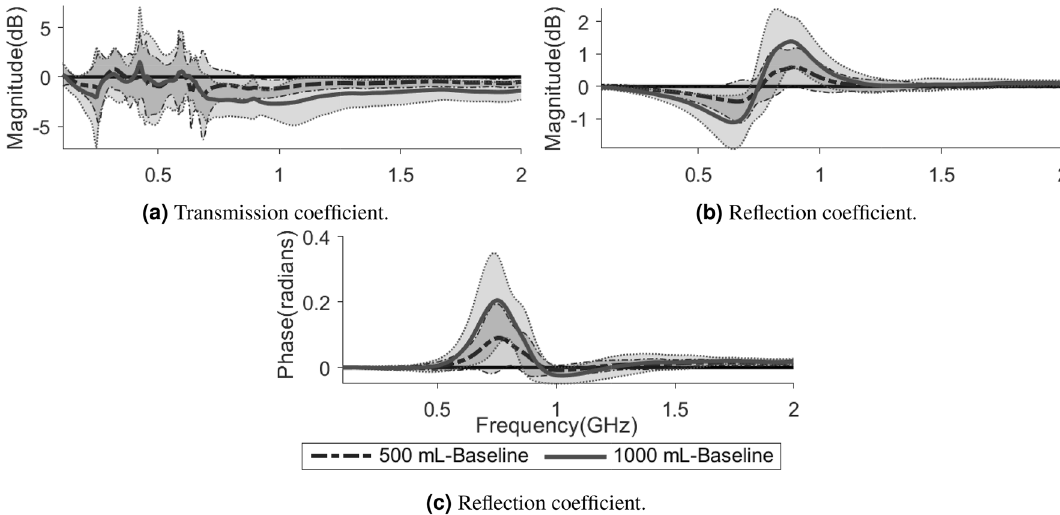
Figure 3. Some examples of the changes relative to baseline caused by hemoperitoneum in transmission coefficient magnitude ( a ) and reflection coefficient magnitude and phase ( b , c ). The lines show the average values across all subjects while the shaded areas show the standard deviations, with the darker shade for 500 mL and the lighter shade for 1000 mL. The solid lines at y = 0 are included to more clearly see the difference from baseline.